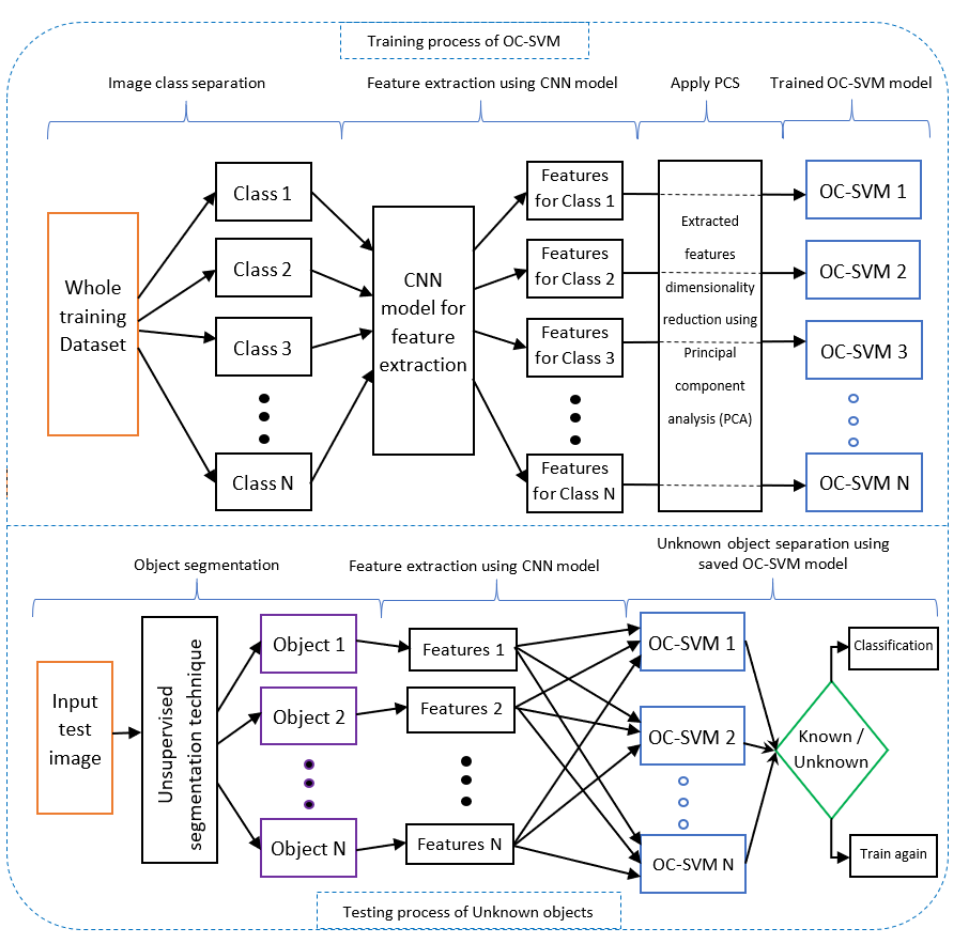
Figure 6. Block diagram of the training and testing process for the proposed incremental learning method.